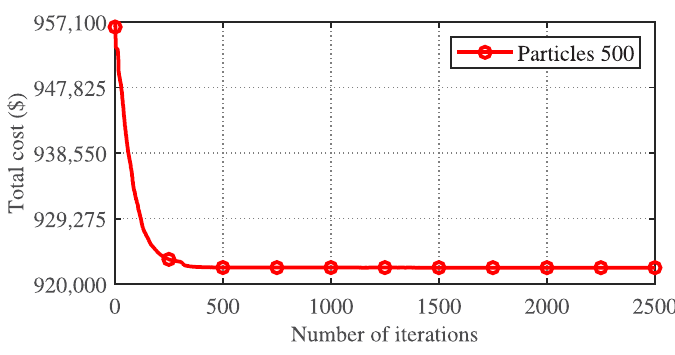
Fig 2. Convergence characteristics of Improved PSO for the CSTHTS problem.